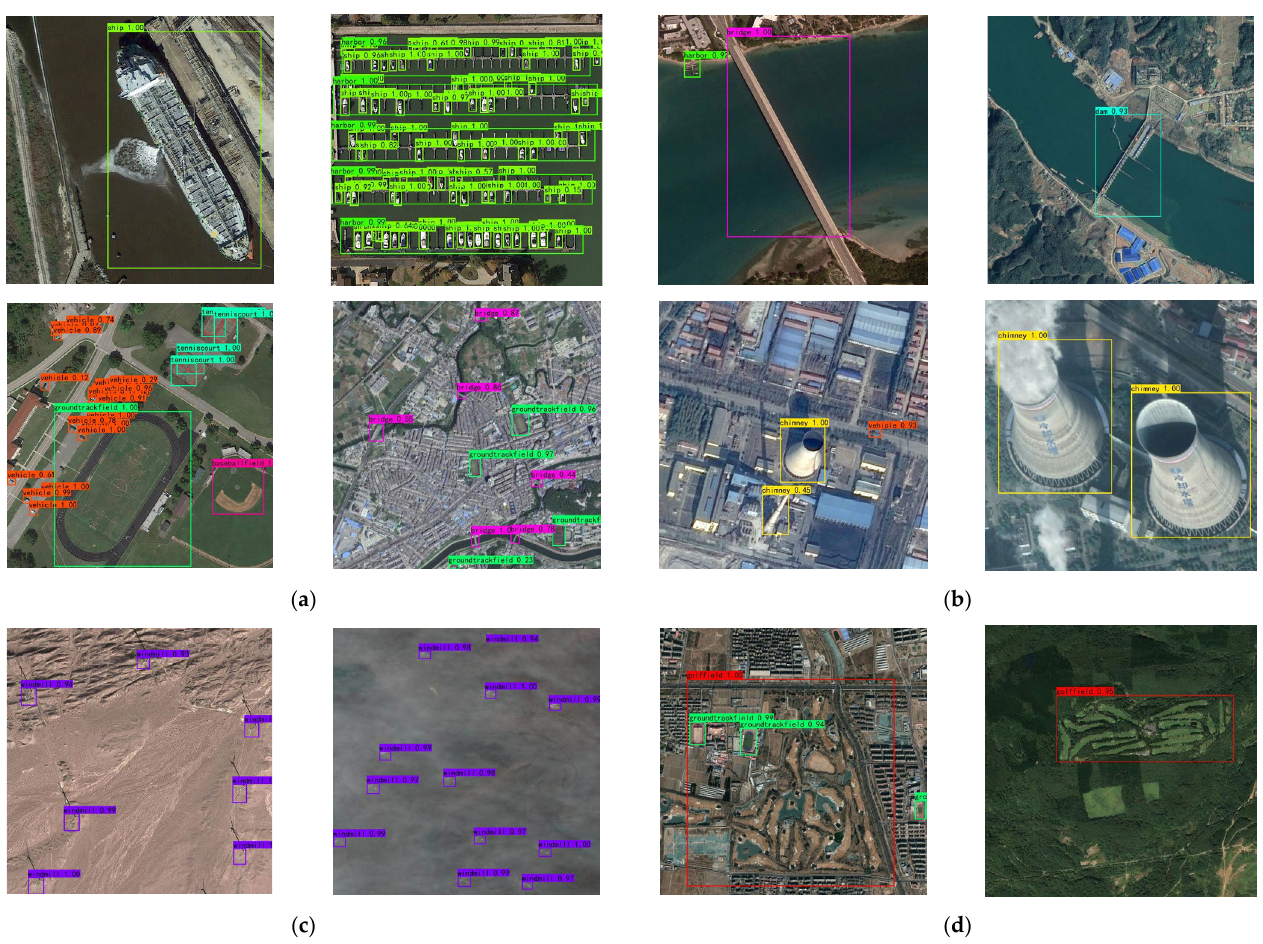
Figure 13. Detection results for diverse objects within the DIOR dataset. ( a ) Different scales for the same type of object; ( b ) Interclass similarity and intraclass variation; ( c ) Various imaging conditions; ( d ) Different seasonal images.